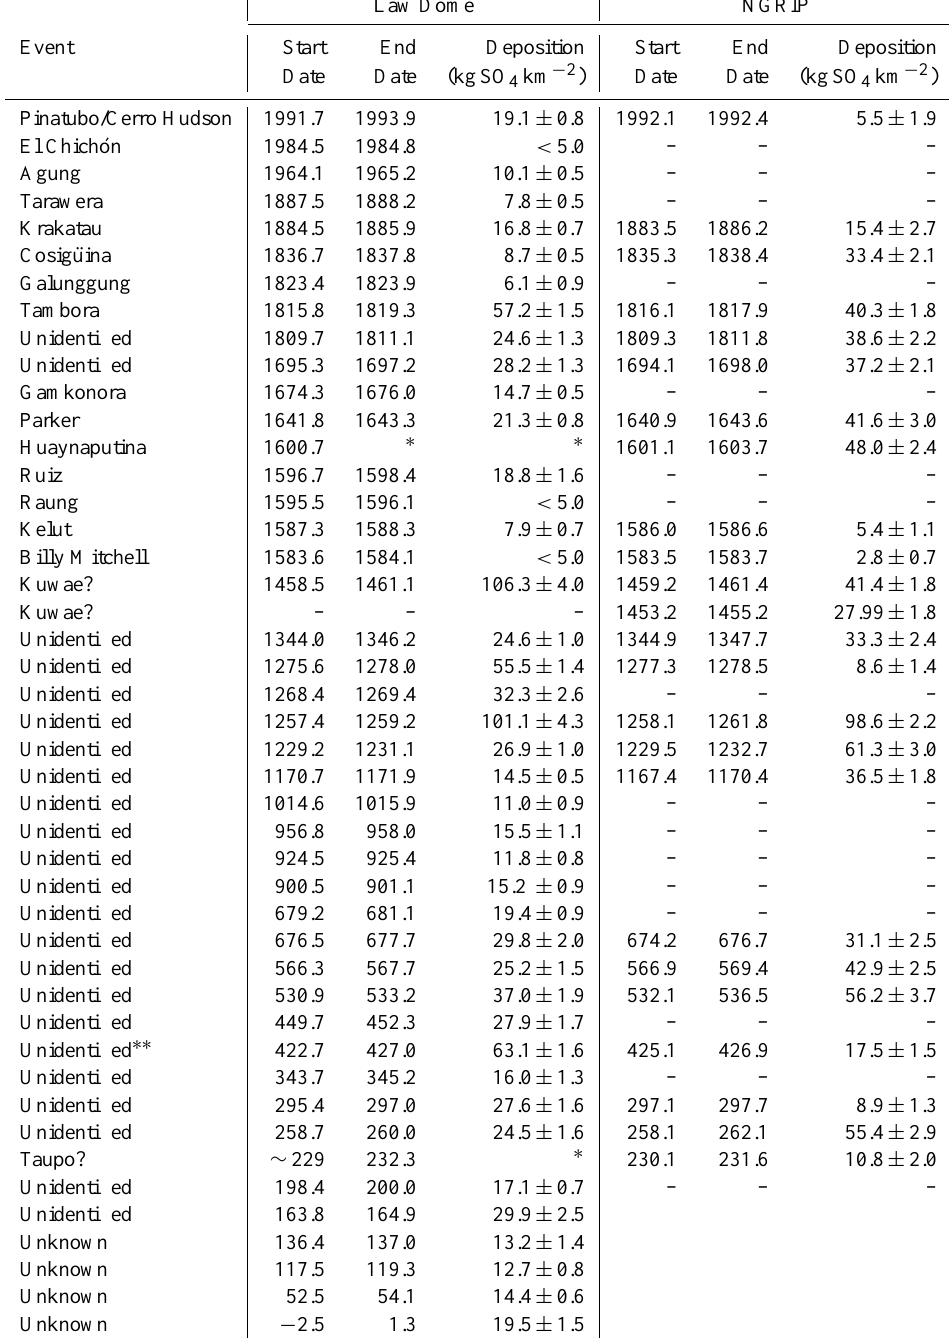
Table 2. Volcanic sulphate deposition at Law Dome. For events identified as inter-hemispheric, NGRIP depositional data are provided